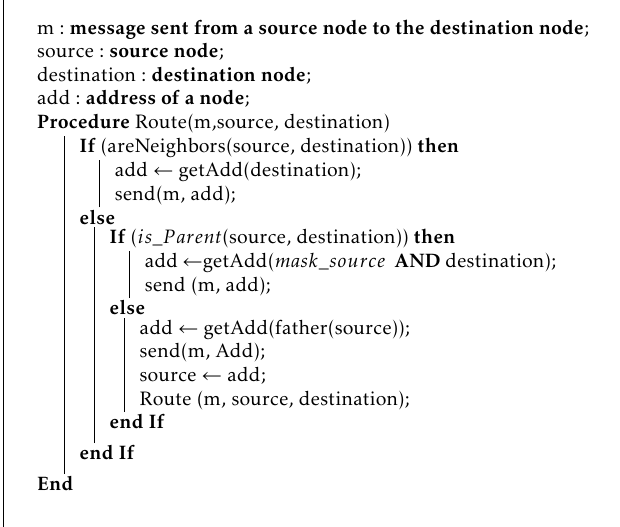
Algorithm 1: Basic forwarding